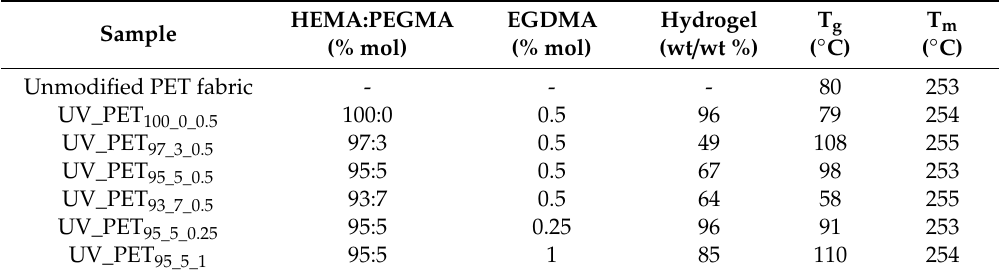
Figure 4. Differential scanning calorimetry (DSC) curves of ( a ) PET, ( b ) UV PET 95:5:0.25 96% hydrogel, and ( c ) UV PHEMA hydrogel. Table 3. Results by DSC for PET fabrics modified with hydrogel, obtained by the photochemical method.